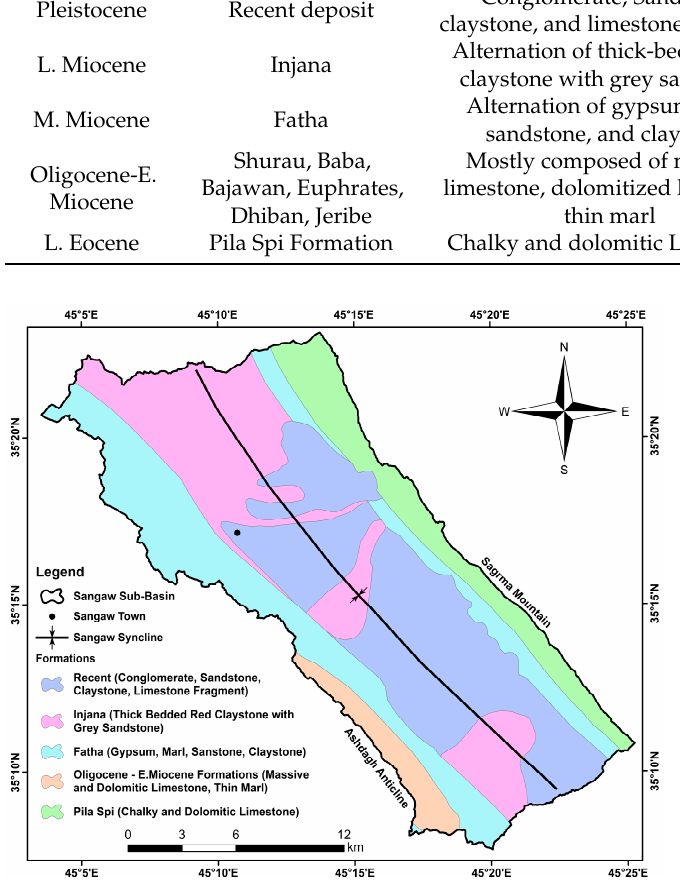
Figure 2. Geological map of the study area.